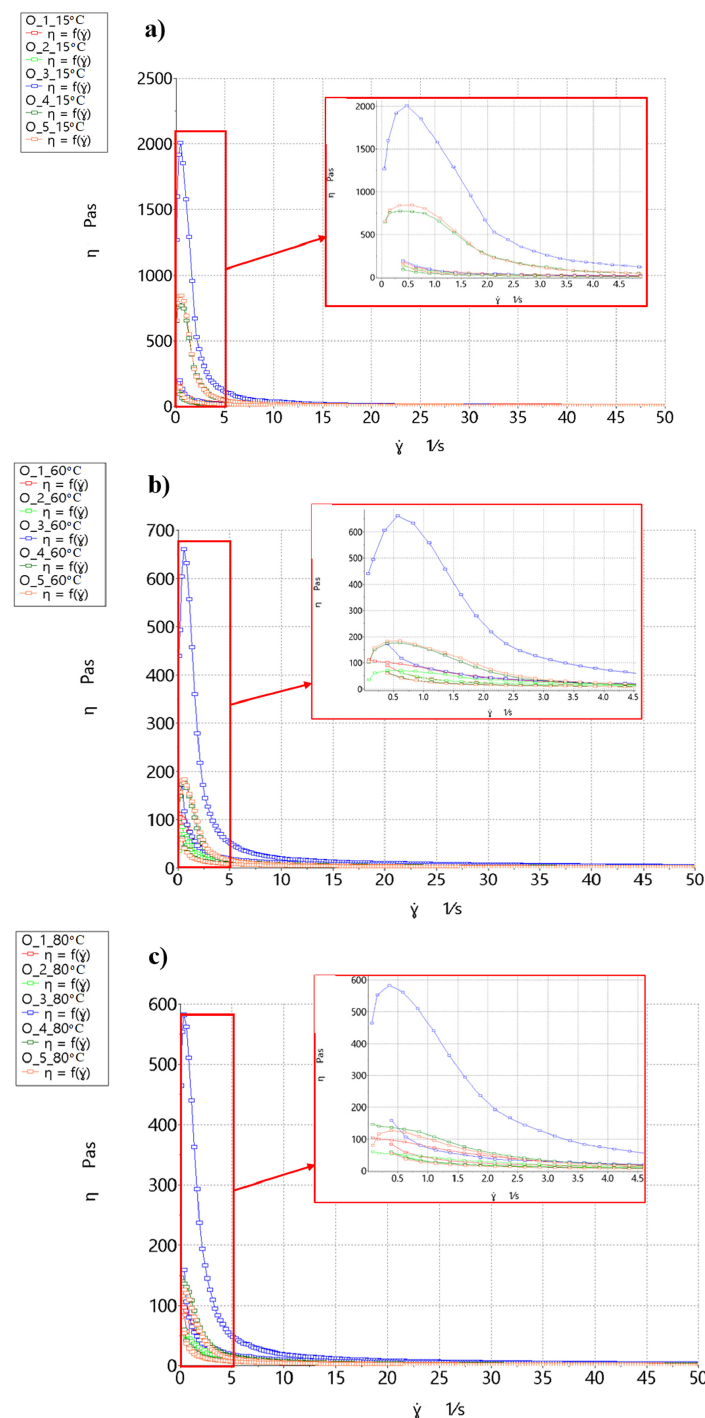
Figure 4. Viscosity in the form of a thixotropy loop of hot trub depending on the temperature: ( a ) 15 ◦ C, ( b ) 60 ◦ C, and ( c ) 80 ◦